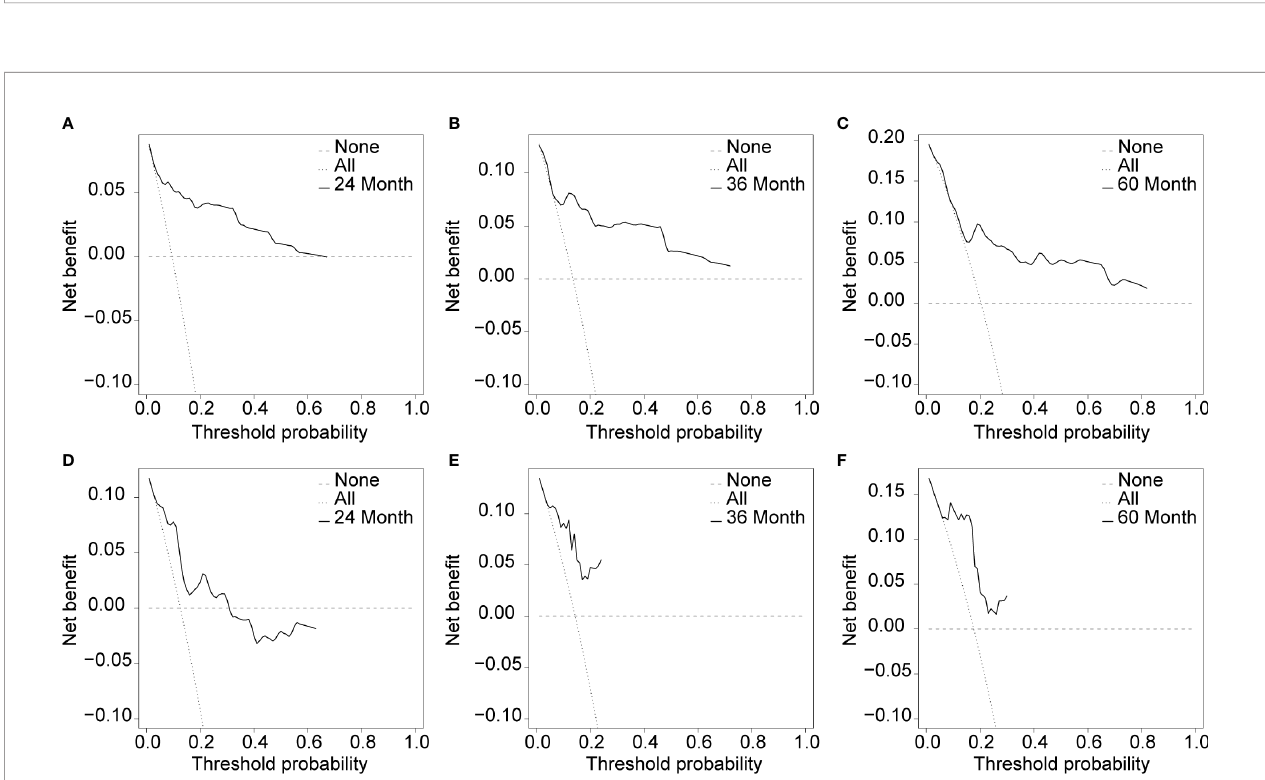
FIGURE 7 | Usefulness evaluation of the training dataset (A – C) and the validation dataset (D – F) in 24, 36, and 60